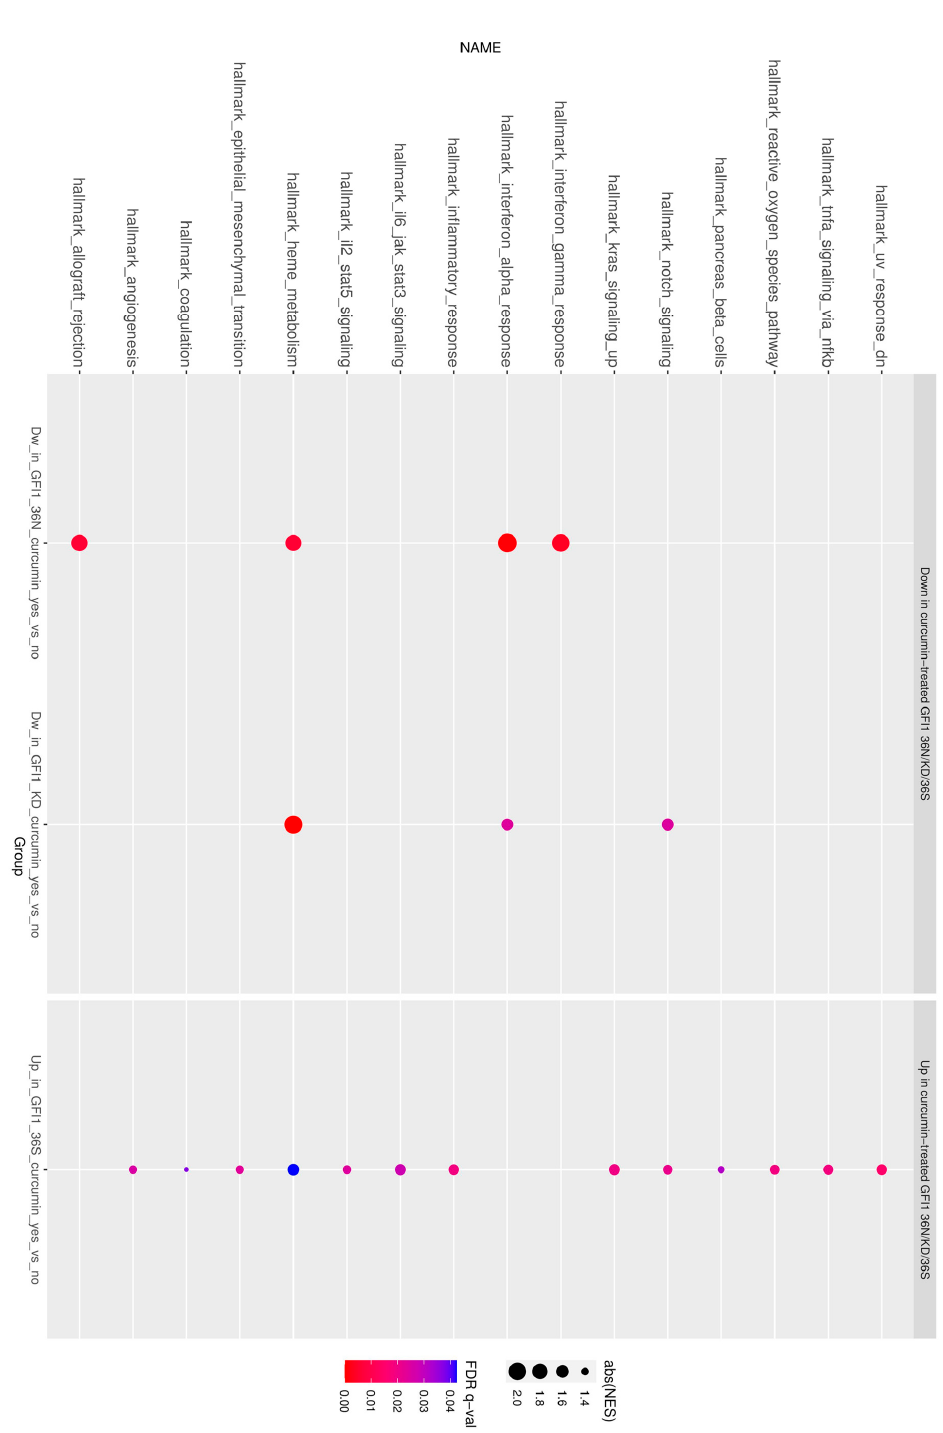
Figure 4. Curcumin treatment significantly affected hallmark Heme-metabolism in GFI1-36N/-KD, NUP98-HOXD13-tg mice. Significantly enriched (FDR q-value < 0.05) hallmark gene sets between curcumin-treated and untreated samples are presented. Genes were ranked by log 2 fold change of normalized peak read counts between curcumin-treated and untreated samples. For genes with multiple associated peaks, the peak with the largest absolute fold change was used. The colour of the dot denotes the FDR q-value and the size of the absolute value of the normalized enrichment score. The columns from left to right respectively demonstrate negatively enriched gene sets in GFI1-36N/ -KD and positively enriched gene sets in GFI1-36S , NUP98-HOXD13-tg curcumin-treated